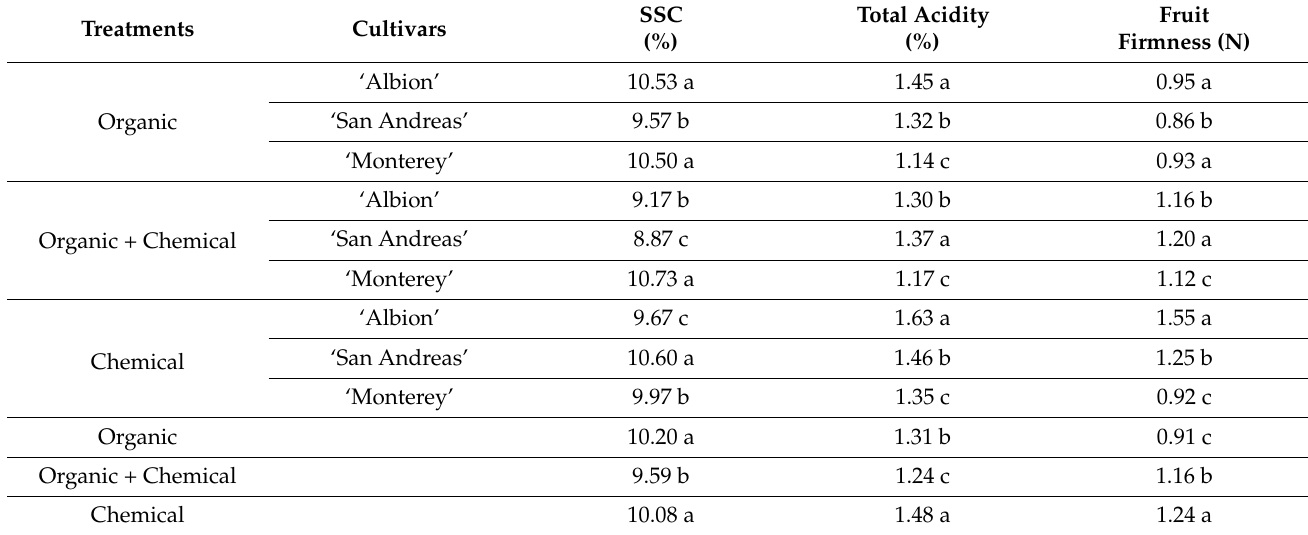
Table 3. Effect of different fertilizer treatments on SSC, total acidity, and fruit firmness of strawberry cultivars. Treatments Cultivars